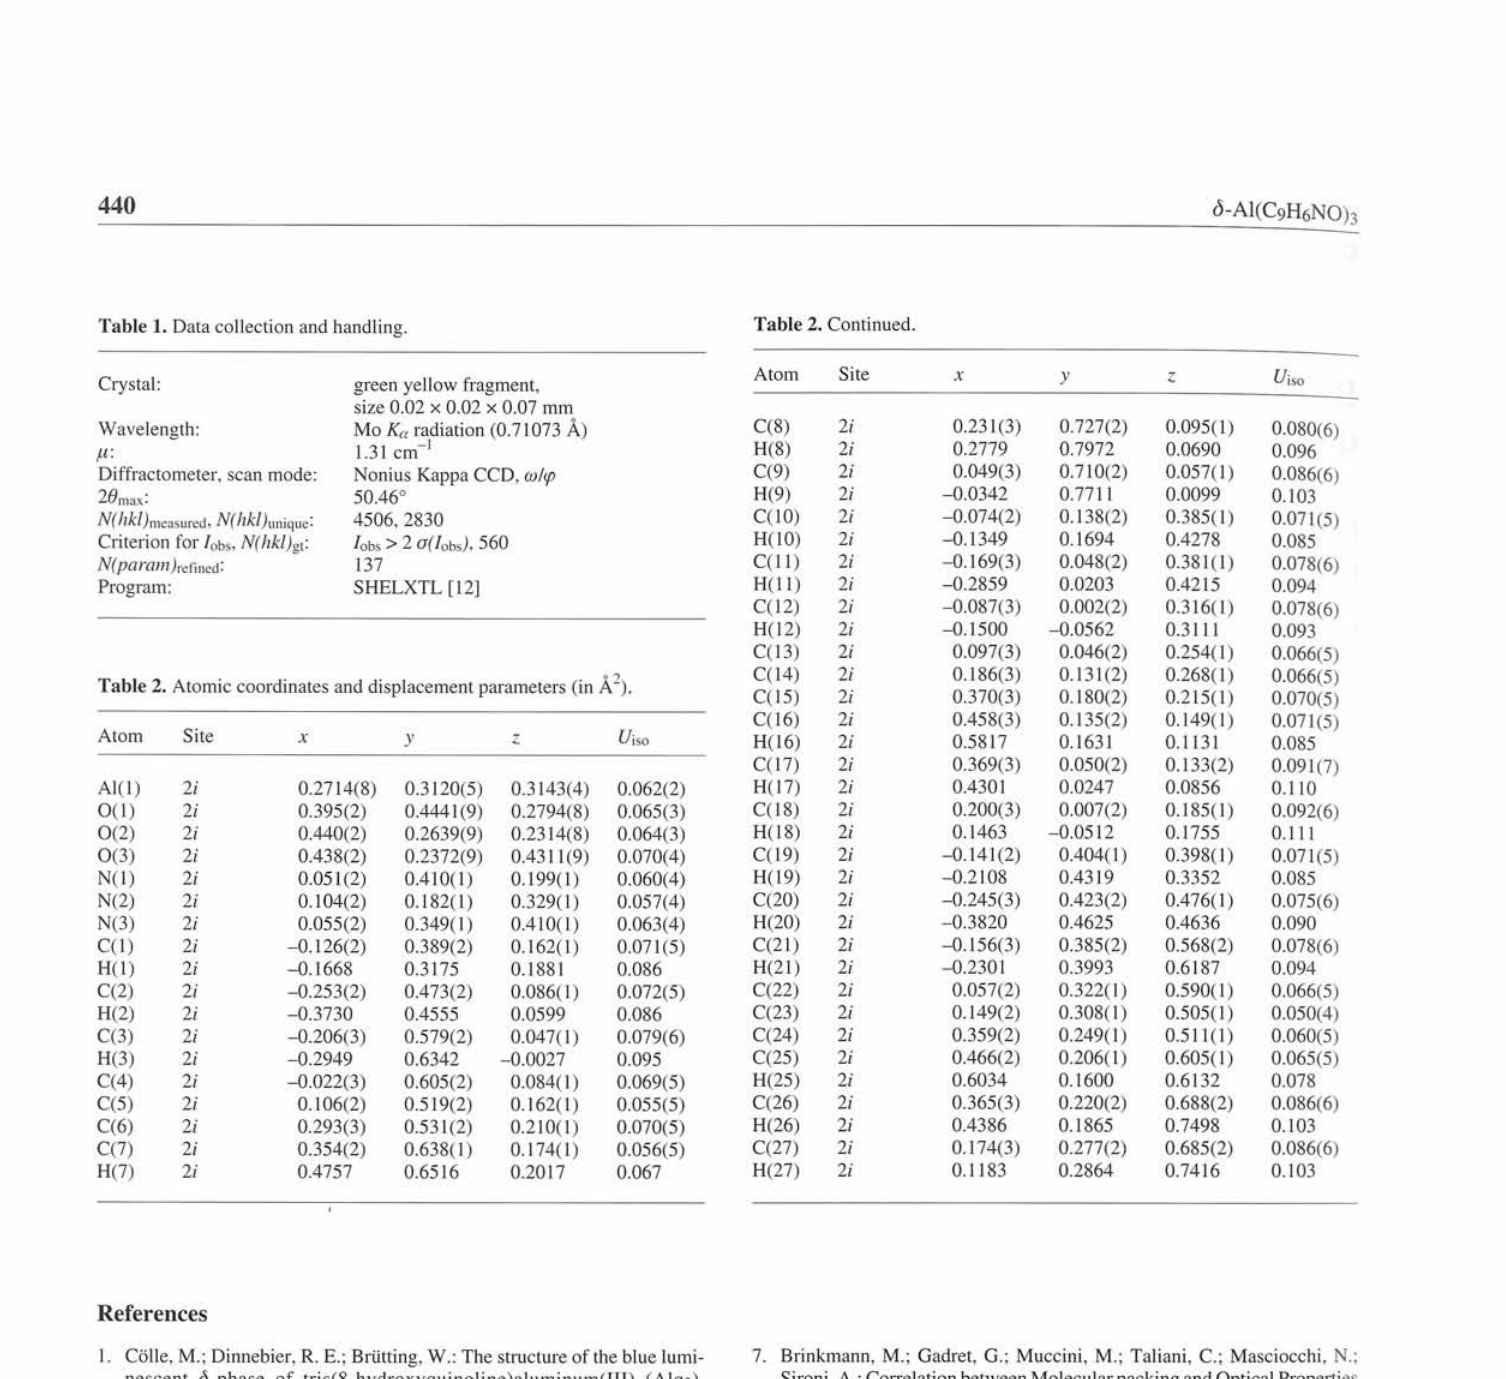
Table 1. Data collection and handling. Table 2. Continued.